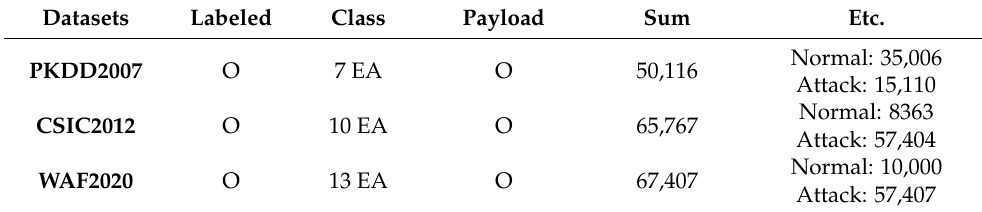
Table 4. Description and datasets (PKDD, CSIC2012, and WAF2020).